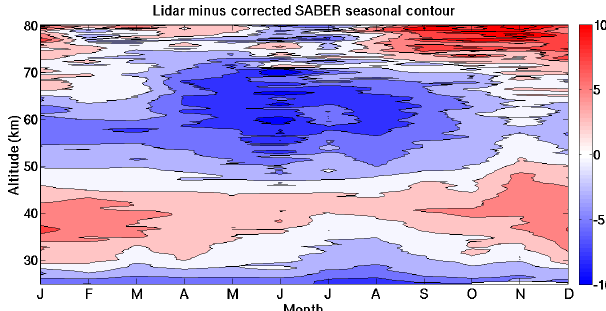
Figure 12. Corrected seasonal temperature differences between the lidar and the vertically displaced SABER temperatures. The mag- nitude of the temperature differences is reduced in both the strato- sphere and mesosphere over the majority of the altitude range when compared to a similar uncorrected temperature difference contour seen in Fig. 4.